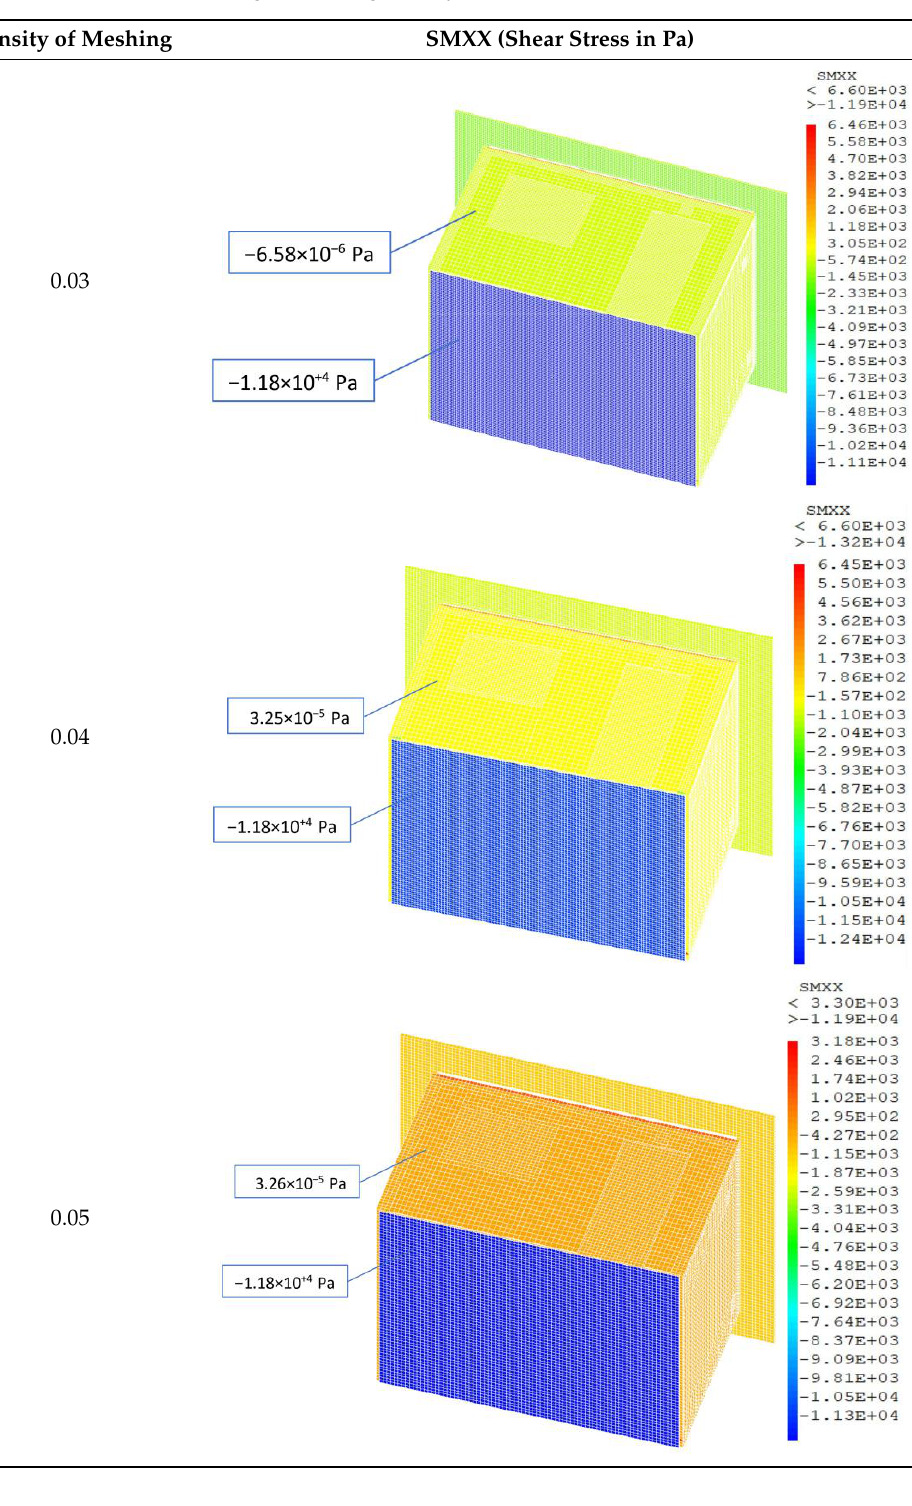
Table 6. Shear values according to meshing density.